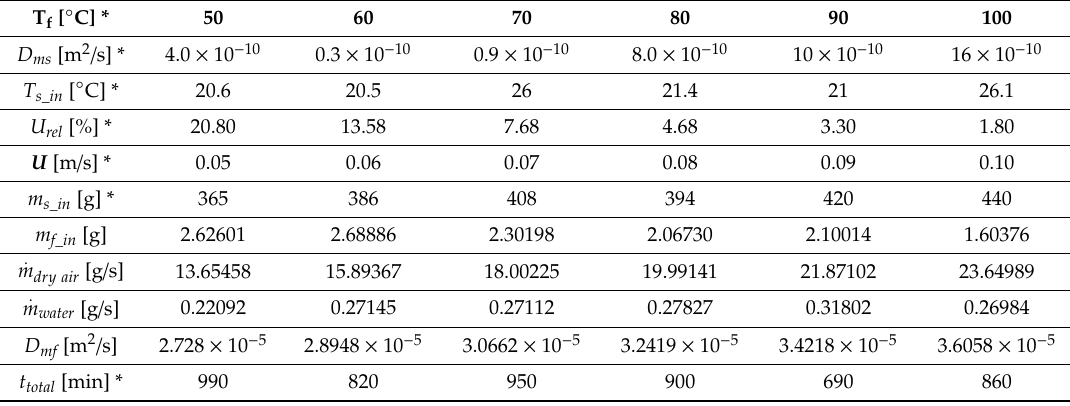
Table 1. Useful data for the numerical simulations of ceramic brick